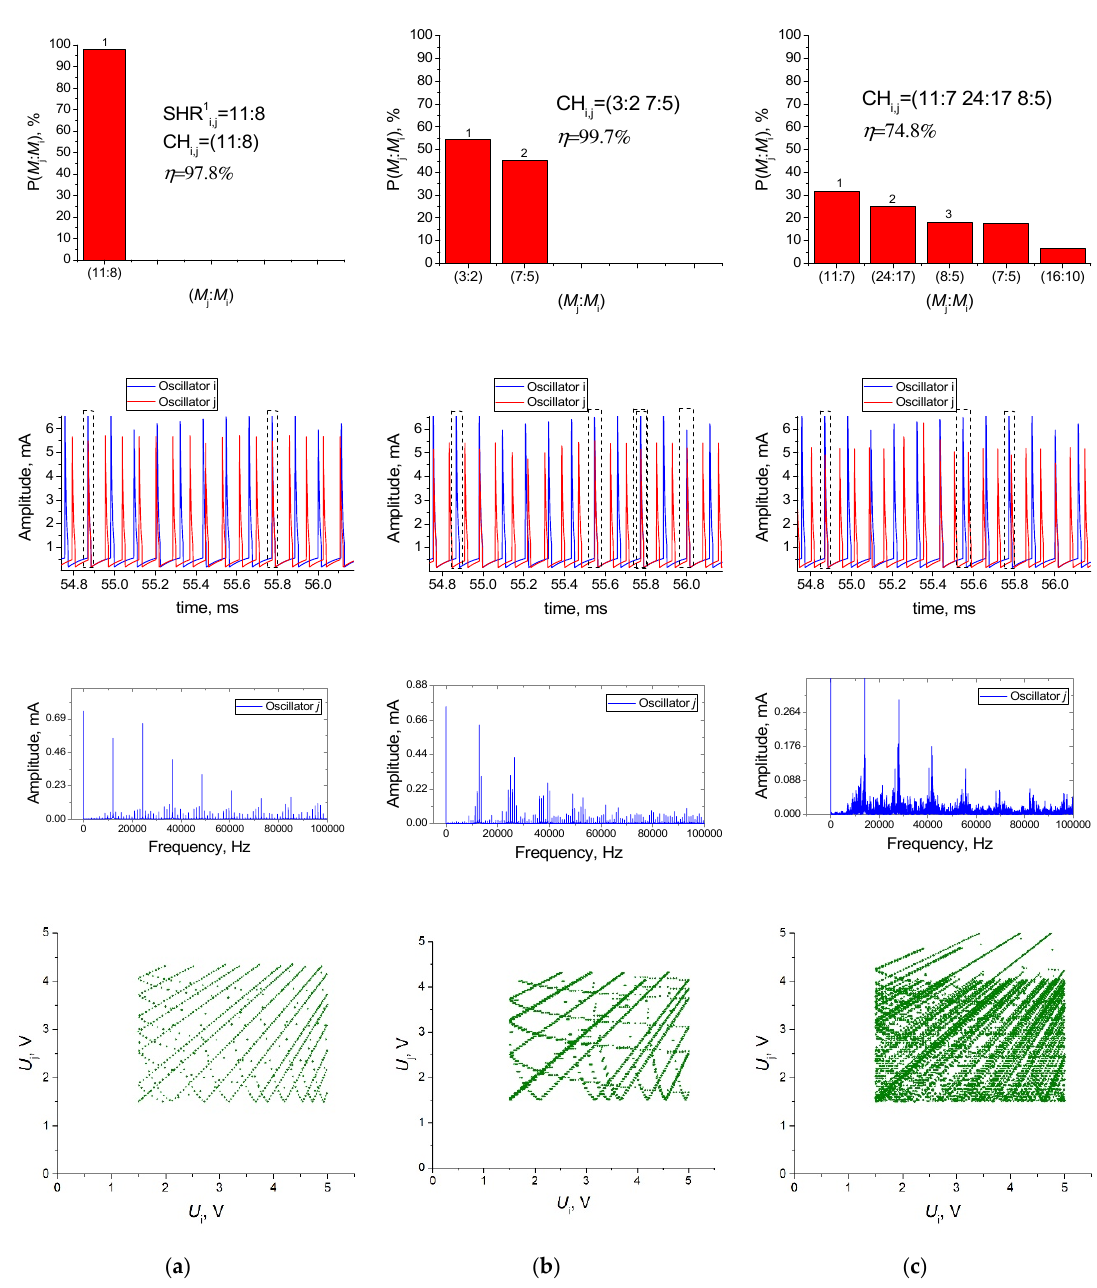
Figure 6. Synchronization characteristics of two oscillators: the main types of histograms occurring during signal processing and the corresponding oscillograms, spectra, and phase diagrams. ( a ) CH i,j = (11:8), ( b ) CH i,j = (3:2 7:5), and ( c ) CH i,j = (11:7 24:17 8:5). The dotted line indicates the synchronous peaks of the two oscillators.